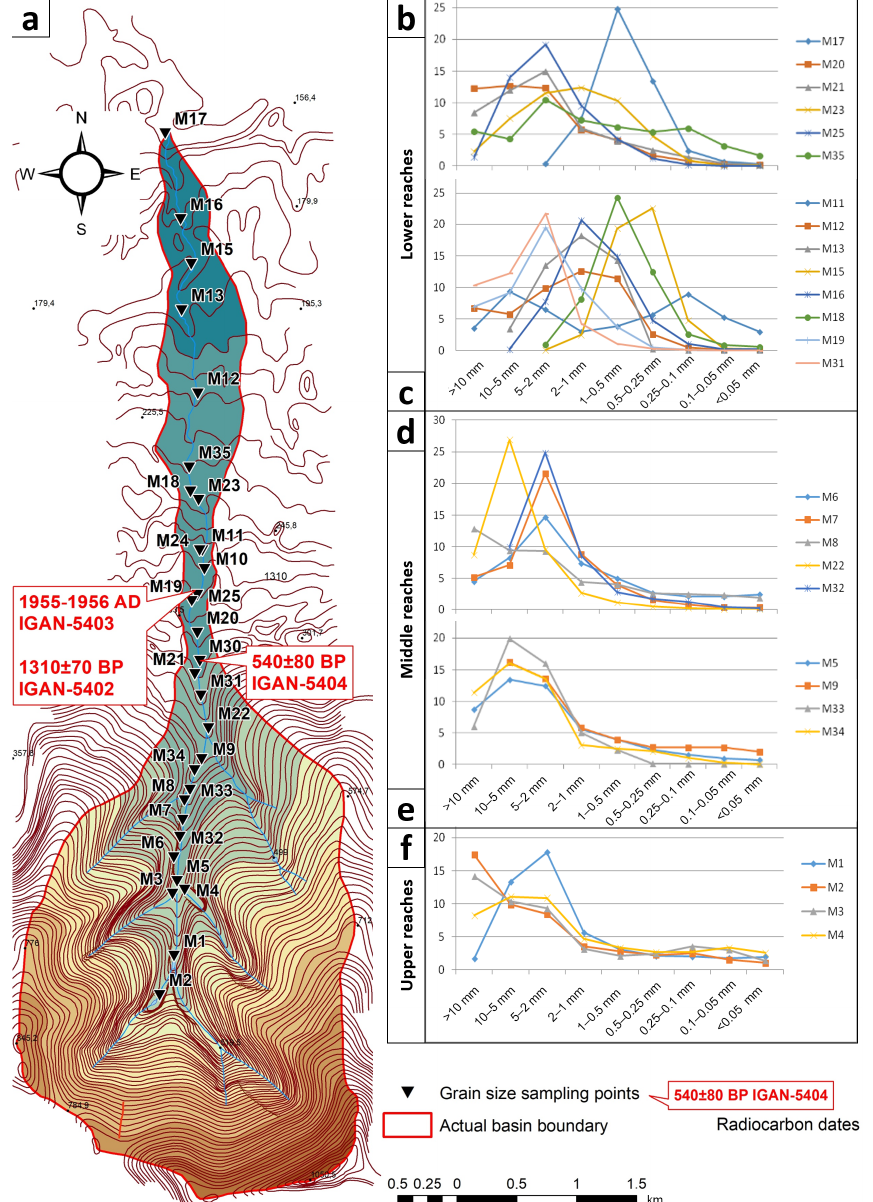
Figure 3. Grain size data of slush flow deposits in the Mannepahkuaj Basin: (a) sampling points on the elevation map. Distribution of granulometric fractions in samples from relic valley bottom features (b, d) and fresh accumulations in the river channel (c, e, f)